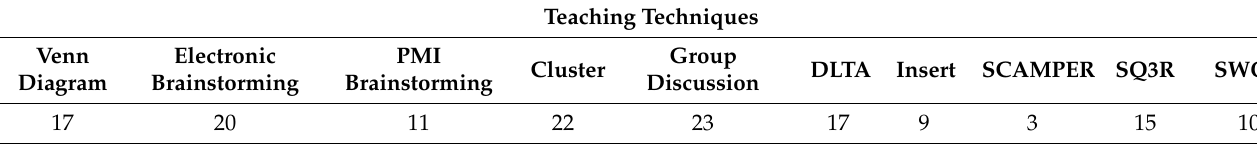
Table 4. Teaching Techniques by teachers. Teaching